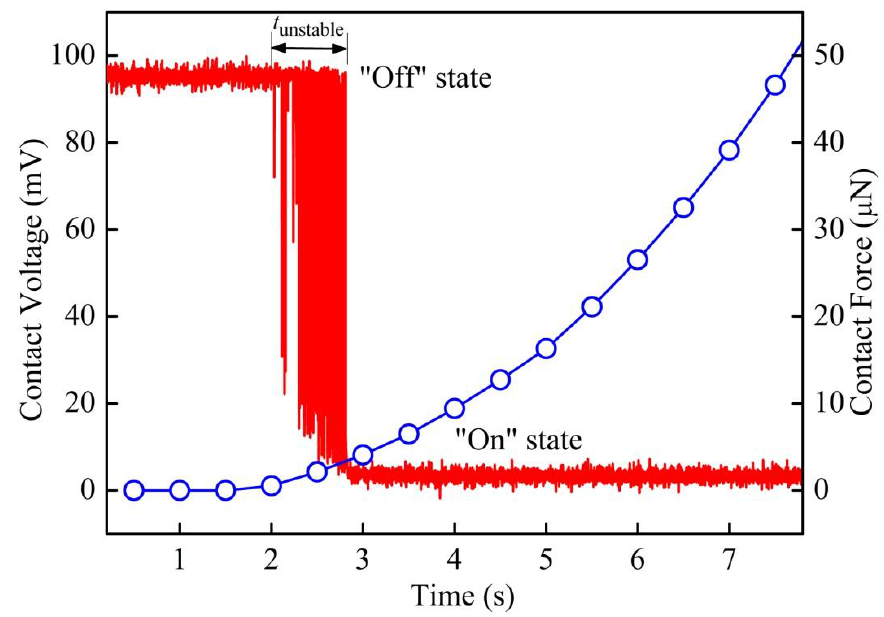
= 95 and 150 mV; Group B, C